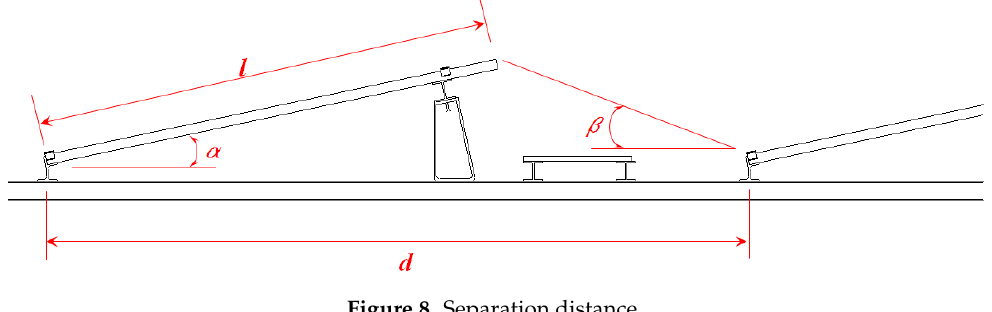
Figure 8. Separation distance.